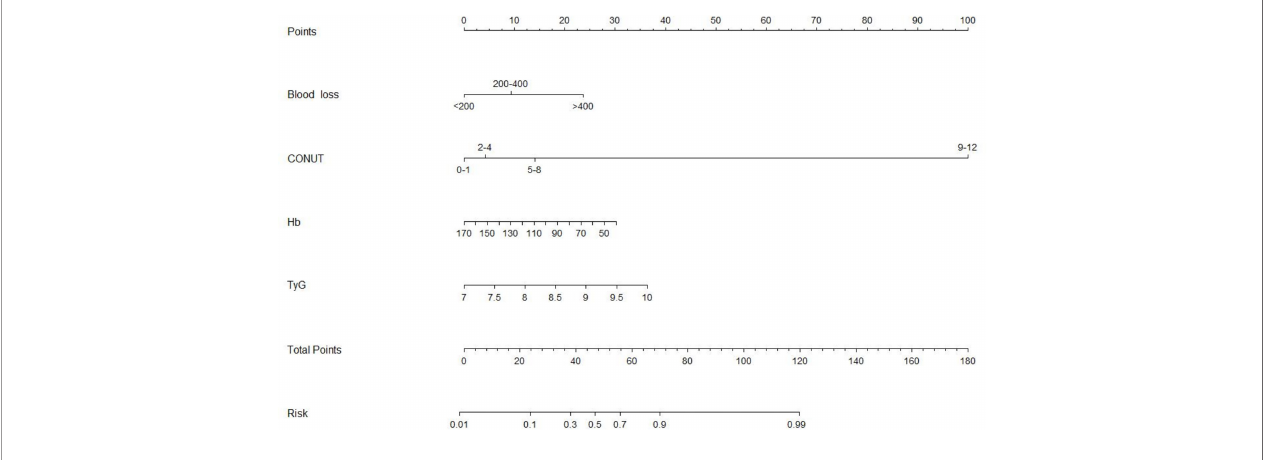
FIGURE 7 | Nomogram predicting the probability of blood